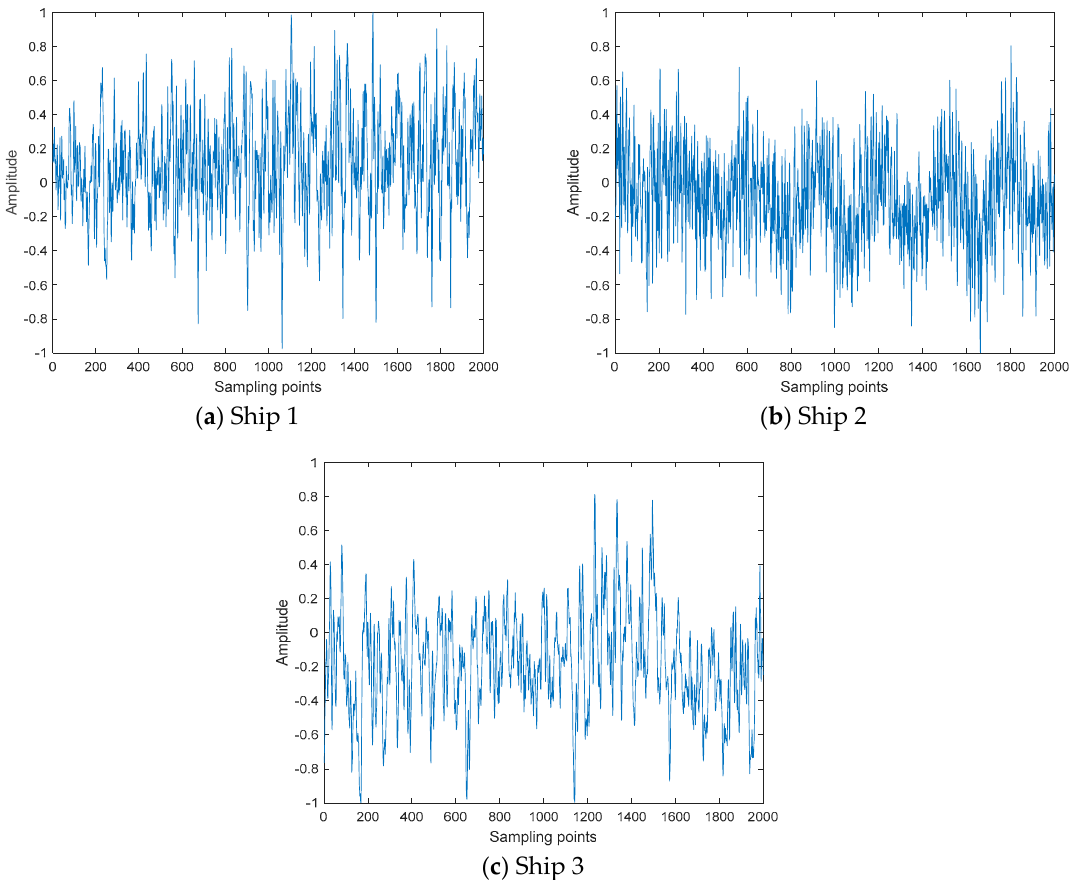
Figure 10. The normalized time-domain waveform for three kinds of ship-radiated noise samples.